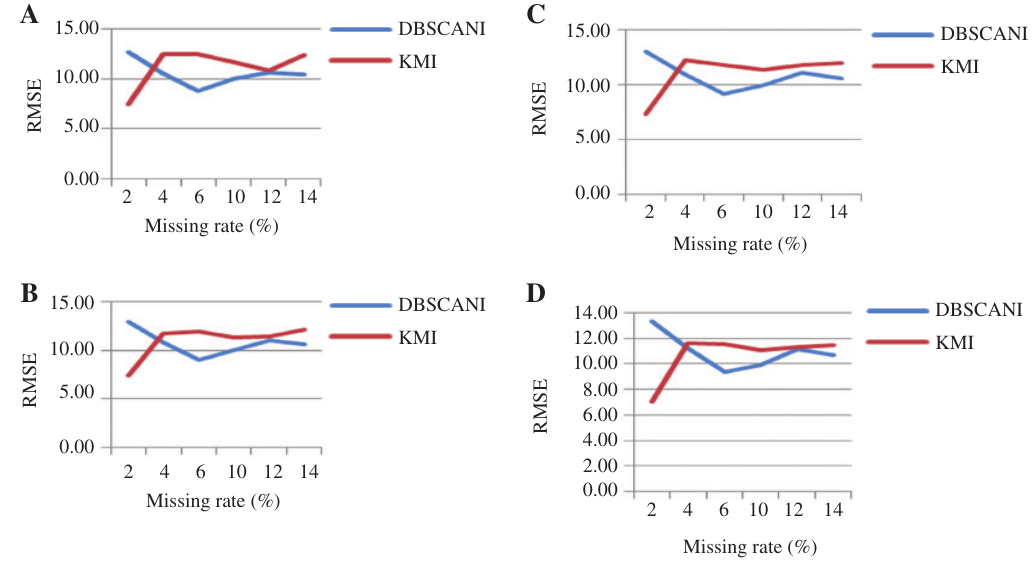
Figure 2: Experimental Results on the 2D Data Set.